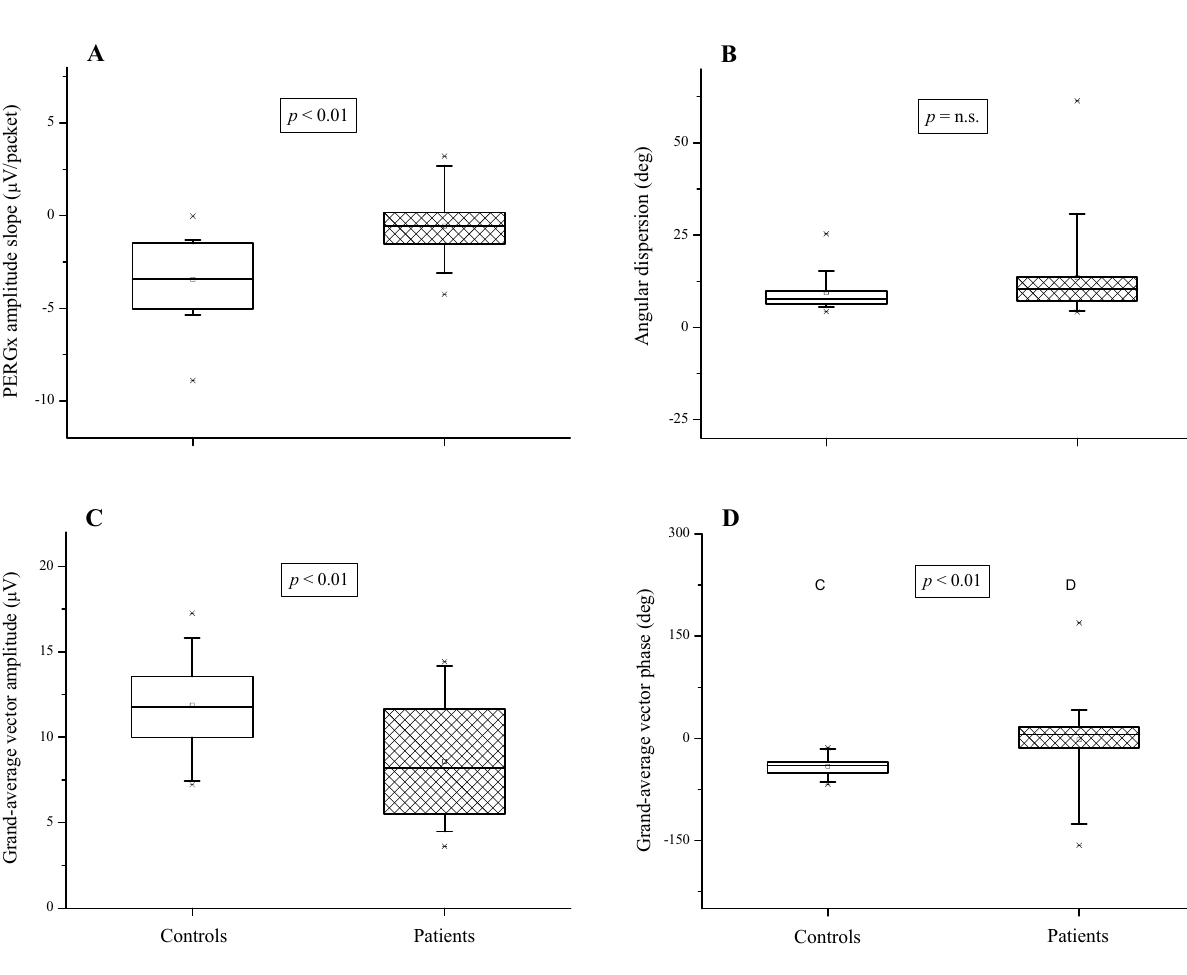
Figure 3. Box plots show the average, median and 25–75% percentiles of PERGx parameters, with whiskers and cross symbols representing the 5–95% and 1–99% percentiles, respectively. The statistical significance ( p -value) of t -test comparisons between group parameters is